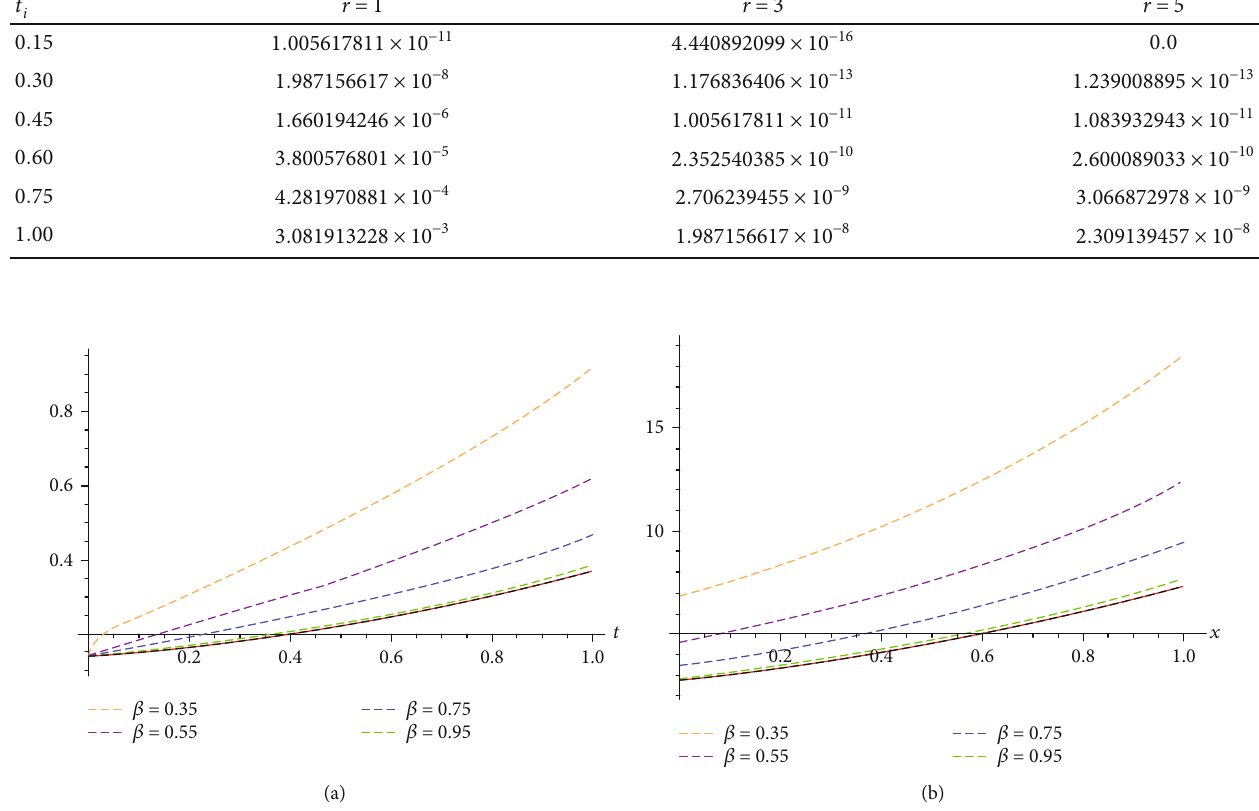
x , t Þ at various β values and fi xed values of x = − 2 and t = 1 and r = 5 , for Example 1.